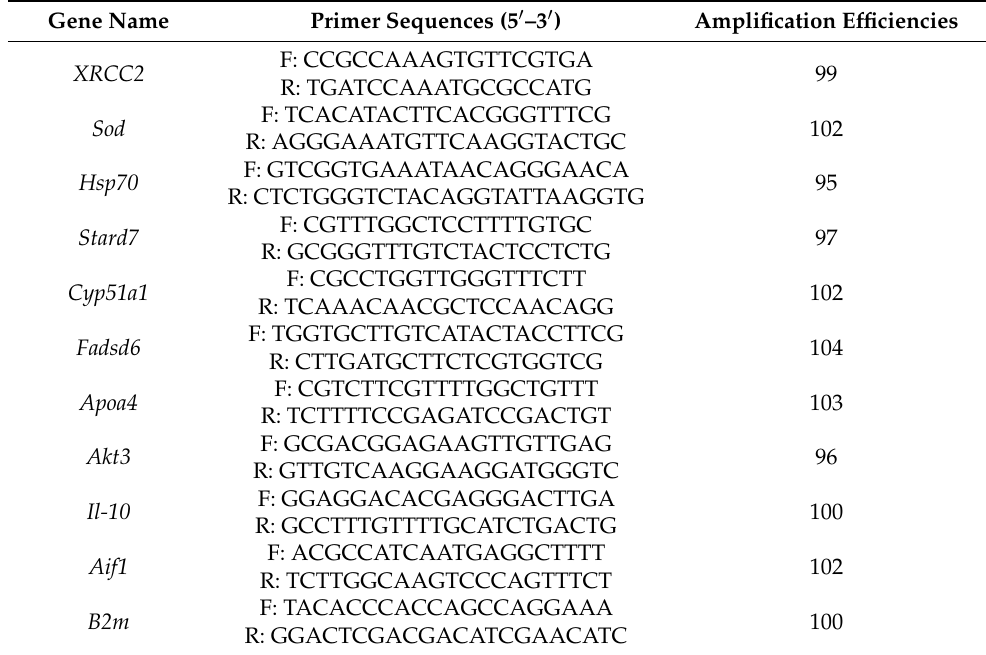
Table 1. Genes used in RT-qPCR and their primer